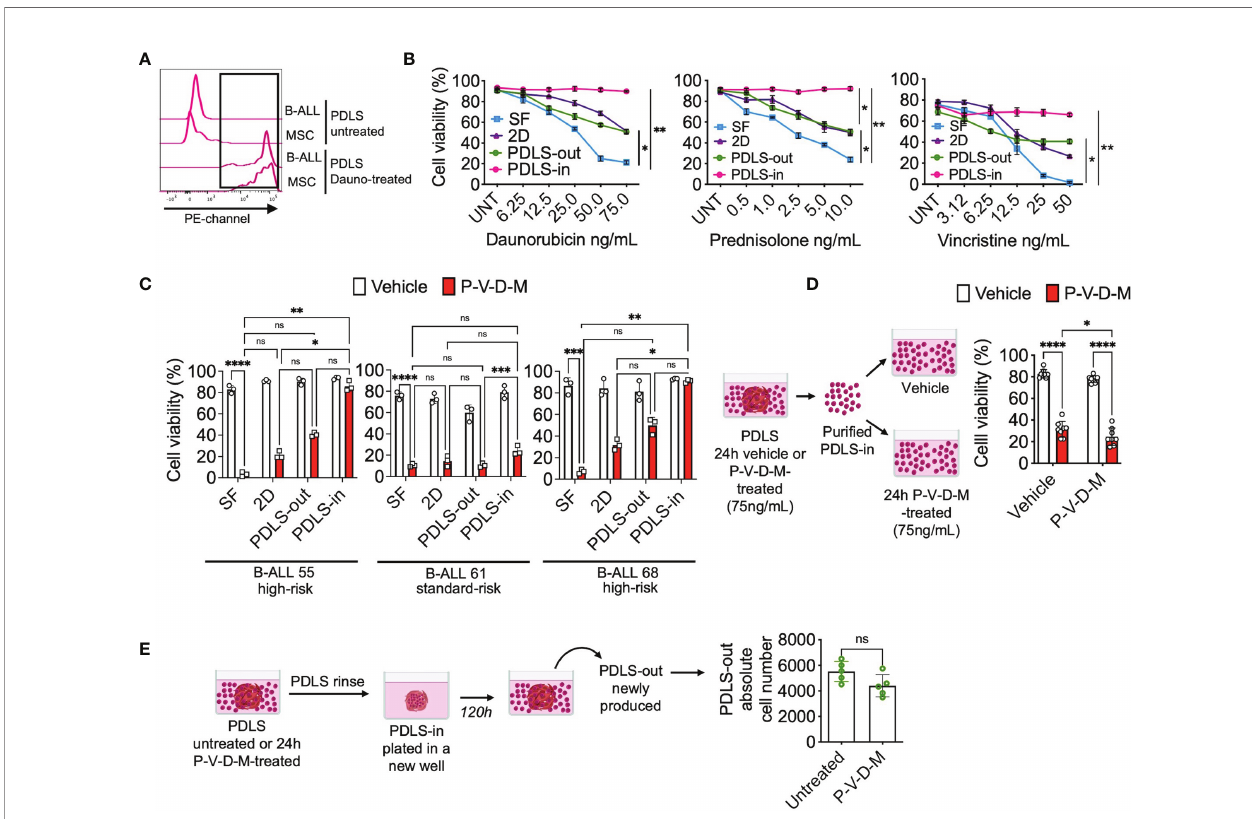
FIGURE 5 | LICs are protected from chemotherapy within PDLS. (A) B-ALL PDLS were incubated with daunorubicin (75 ng/ml) for 1 h and enzymatically disrupted; red fl uorescence was determined in CD45 + (B-ALL) and MSCs by FACS ( n = 5). (B) Primary B-ALL blasts were cultured in SF, 2D and PDLS and CD45 + cell viability evaluated upon 24-h treatment with daunorubicin, prednisolone, and vincristine ( n = 3), or (C) combined chemotherapy: daunorubicin [75 ng/ml], prednisolone [10 ng/ml], vincristine [50 ng/ml], and methotrexate [5 mM] (P-V-D-M). (D) Viable leukemic cells recovered from PDLS-in untreated or 24-h P-V-D-M-treated were re- exposed to the drugs for 24 h and their viability was measured by FACS ( n = 5). (E) PDLS P-V-D-M-treated were replated; upon 120 h, PDLS-out leukemia re- emerging was recorded ( n = 7). B-ALL, B-cell acute lymphoblastic leukemia; PDLS, patient-derived leukemia spheroids; MSCs, mesenchymal stromal cells; FACS, Fluorescence-activated cell sorting; NS, non-signi fi cant. *P < 0.05; **P < 0.01; ***P < 0.001, ***P < 0.0001. Error bars represent